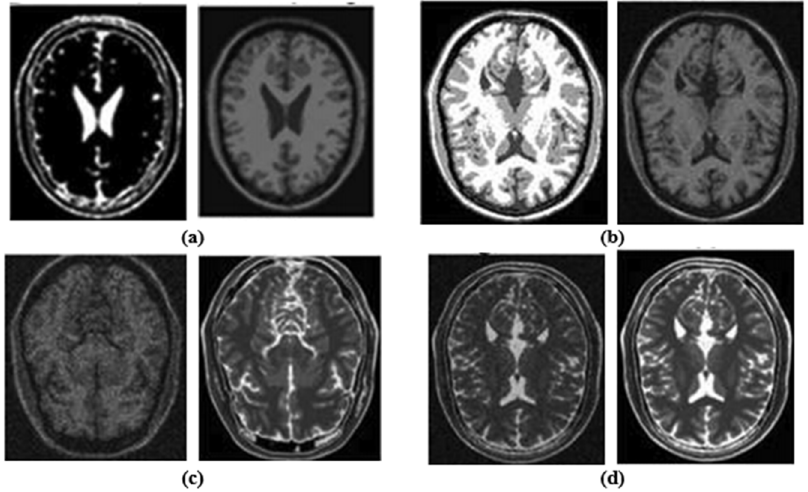
Figure 2. The corresponding results of preprocessing step.